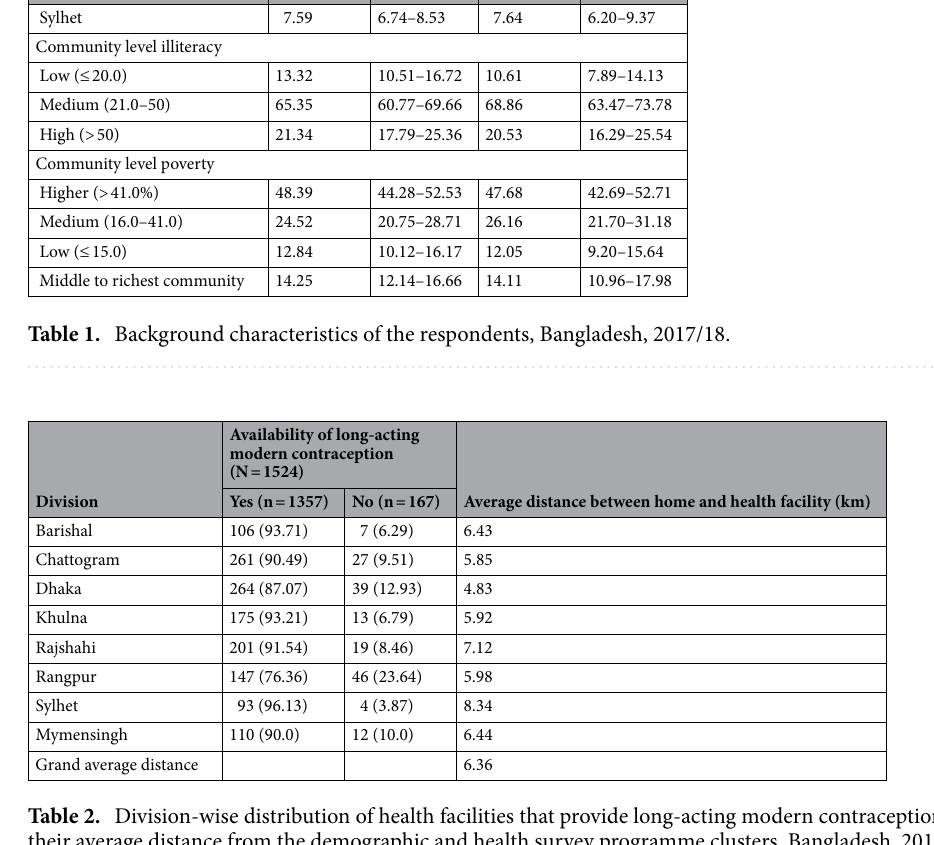
Table 2. Division-wise distribution of health facilities that provide long-acting modern contraception and their average distance from the demographic and health survey programme clusters, Bangladesh, 2017/18.